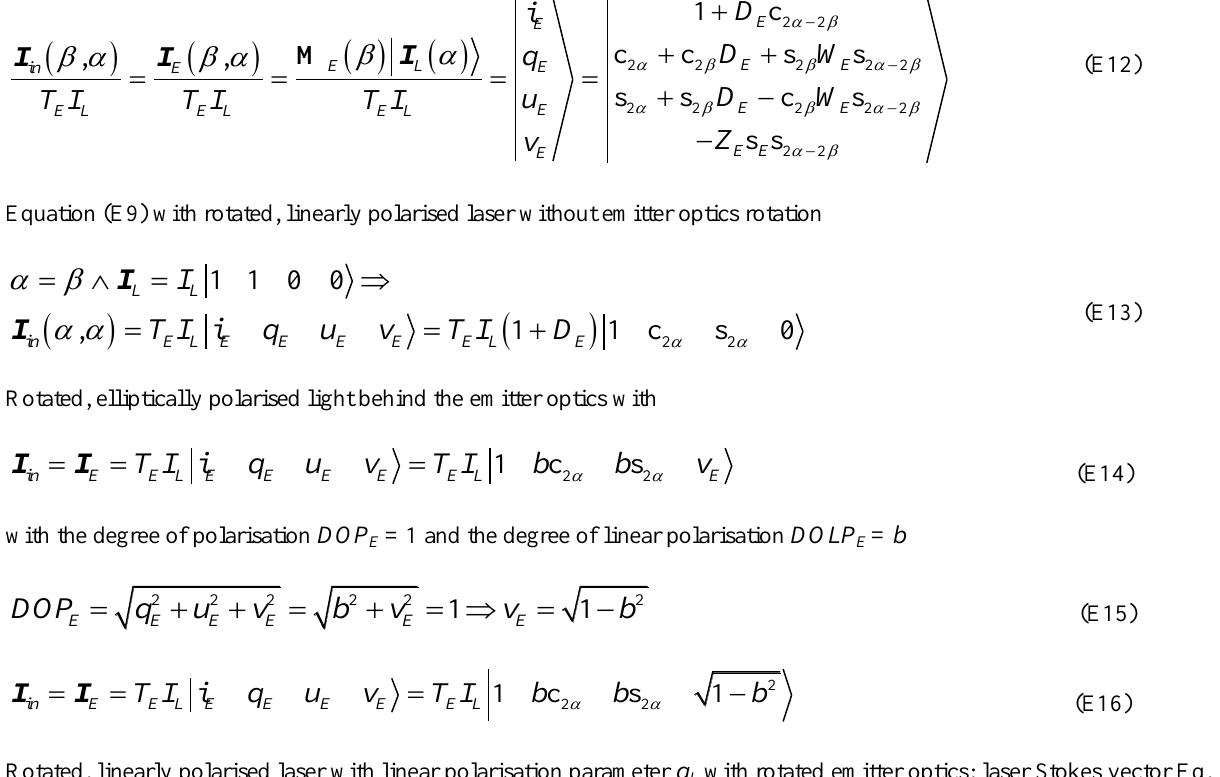
with rotated emitter optics: laser Stokes vector Eq. L